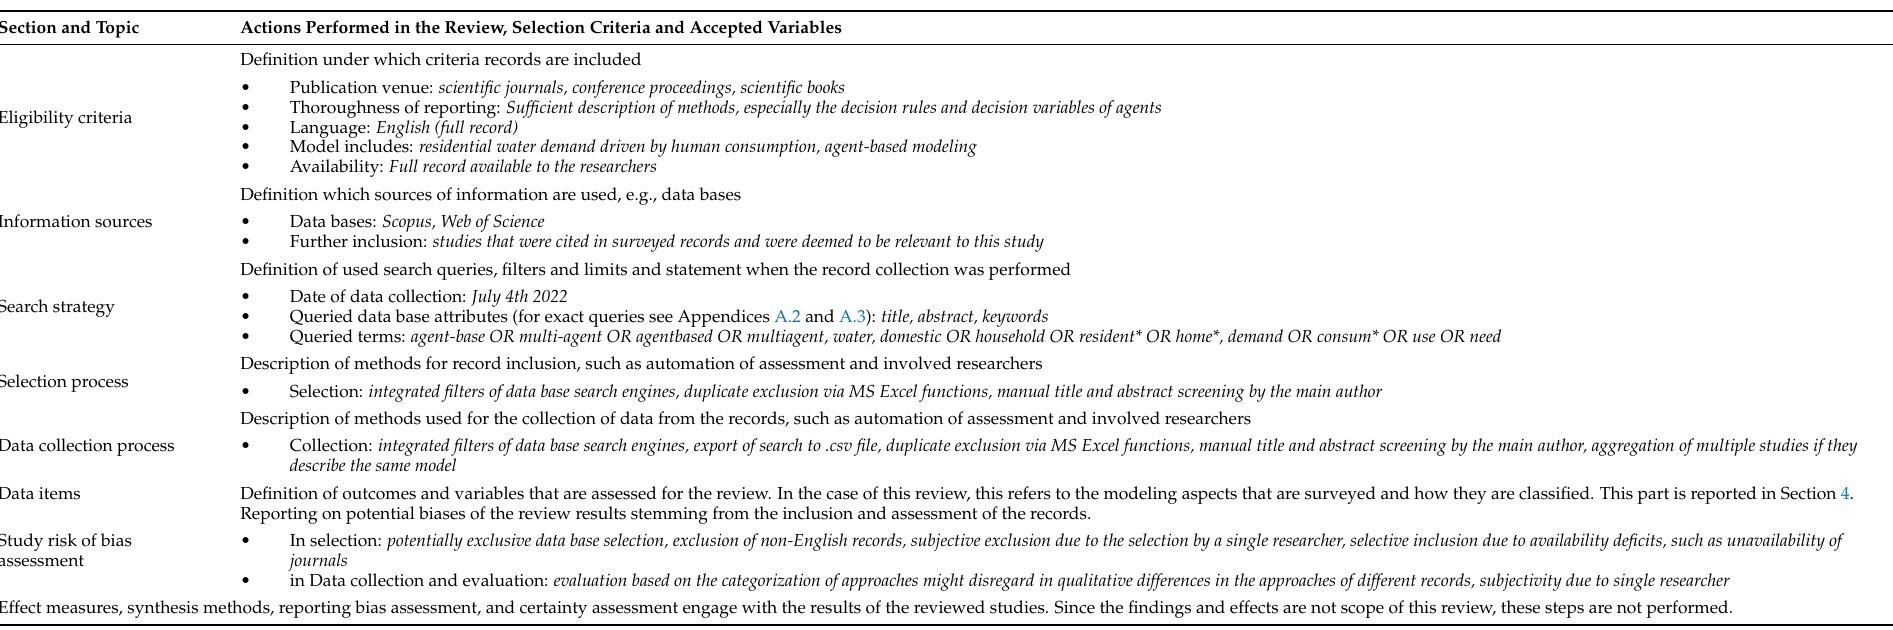
Table A1. Performed steps of the PRISMA methods and adjustments to the method for this